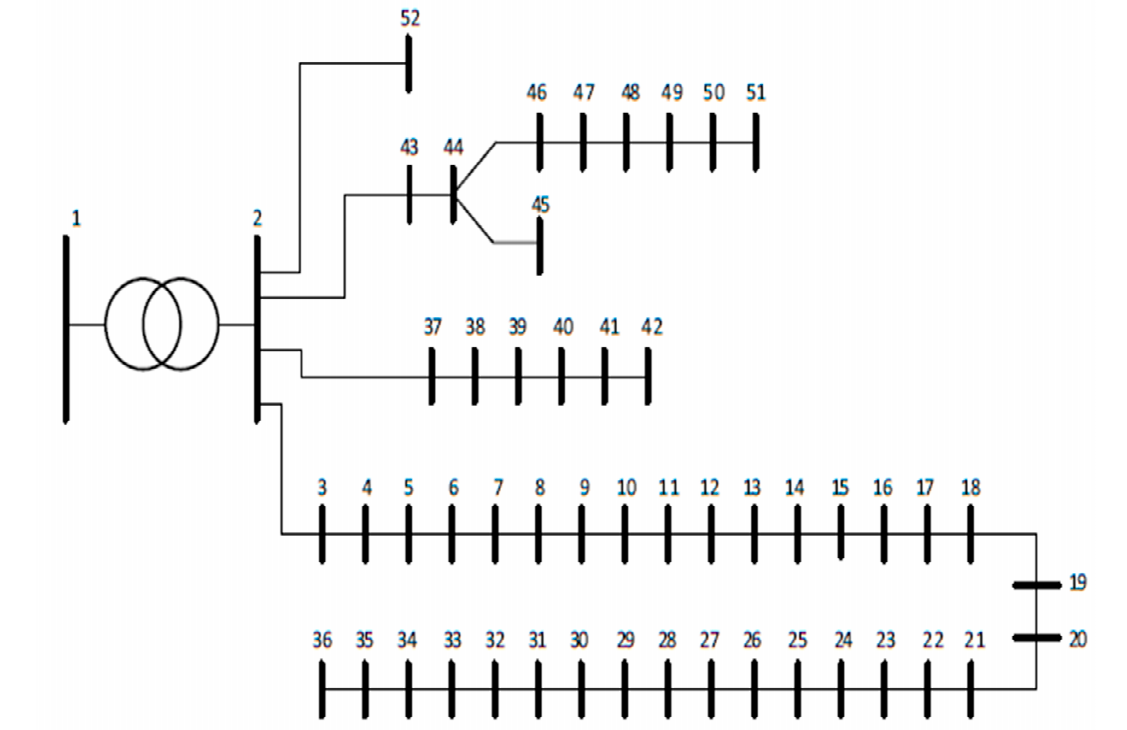
Figure 11. Errors for 30%, 60% and 90% of nonlinear load scenarios.